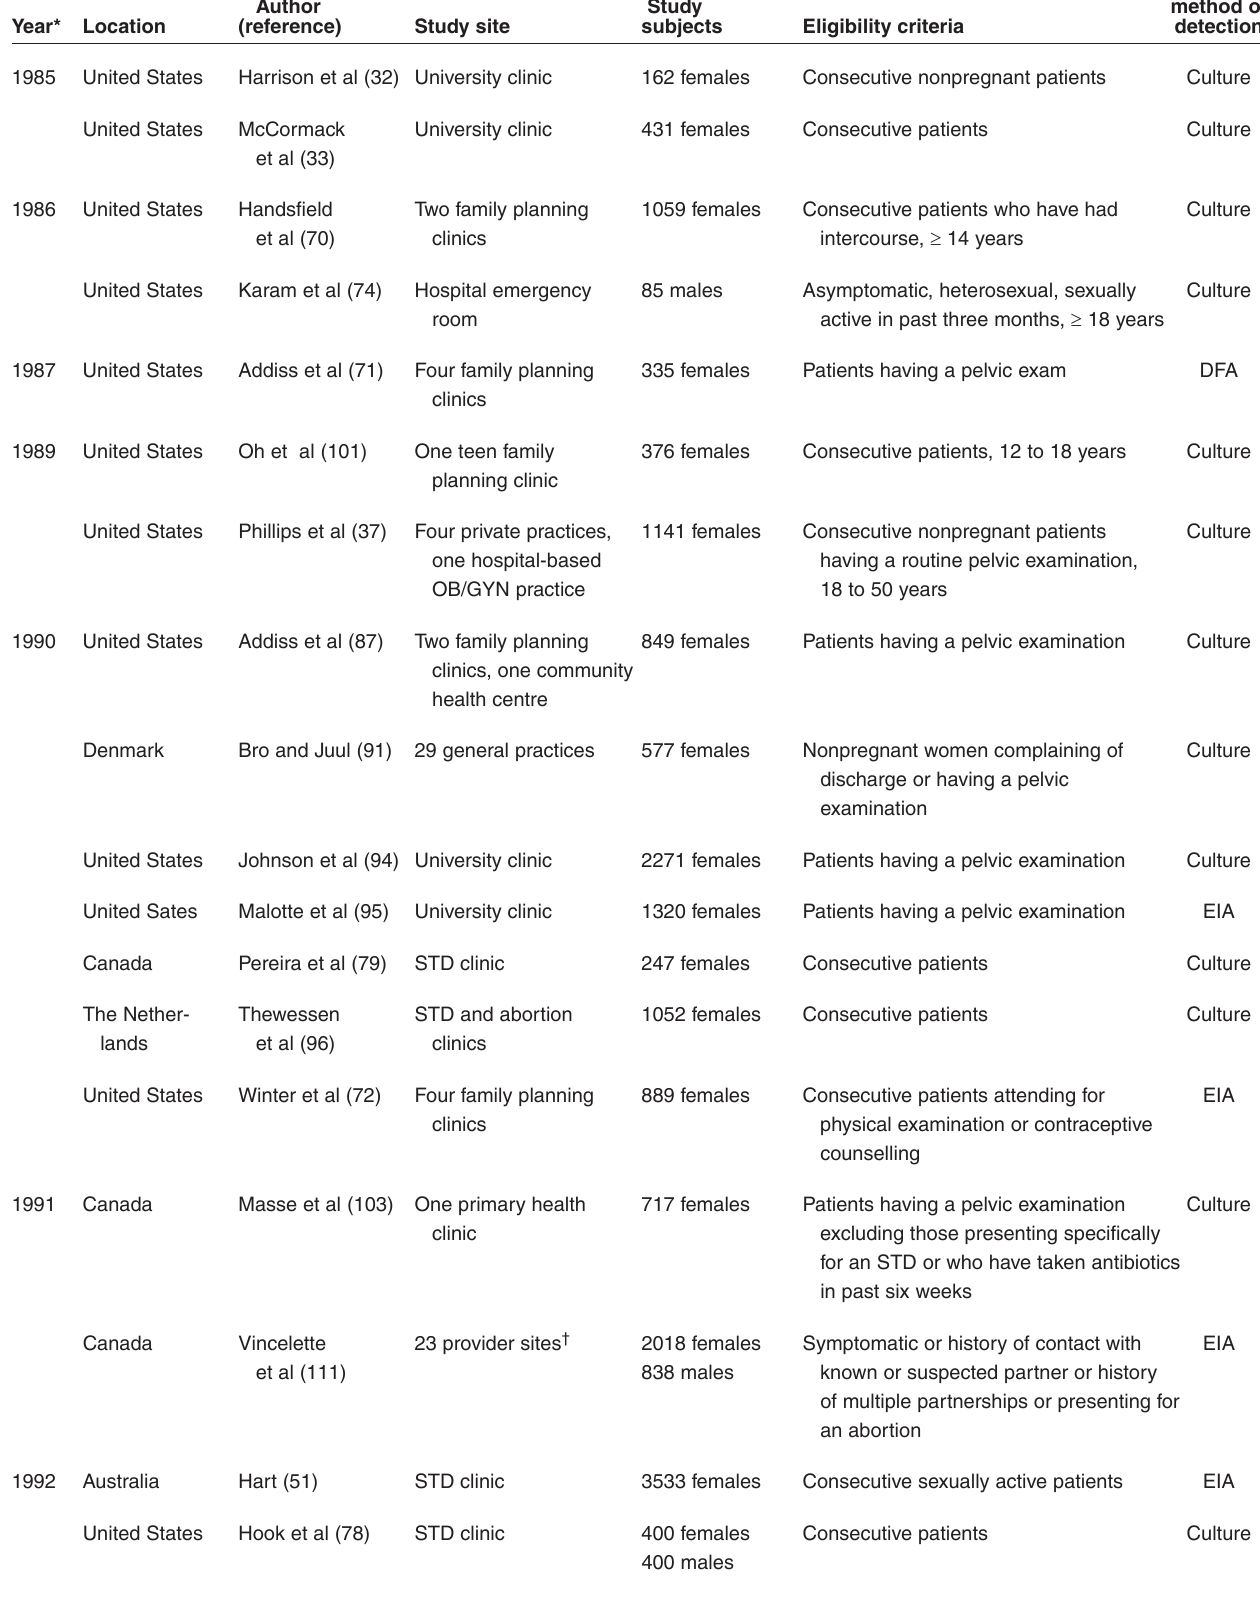
TABLE 1 Description of cross-sectional studies of